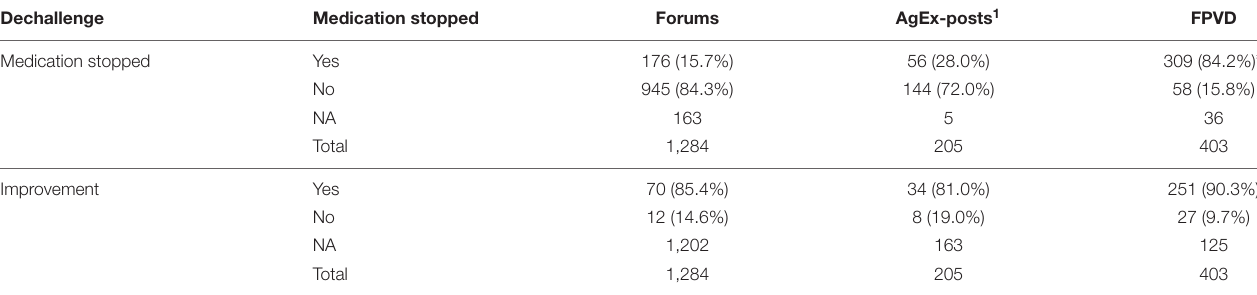
TABLE 6 | Comparison of the dechallenge between the sources. Dechallenge Medication stopped Forums AgEx-posts 1 FPVD Medication